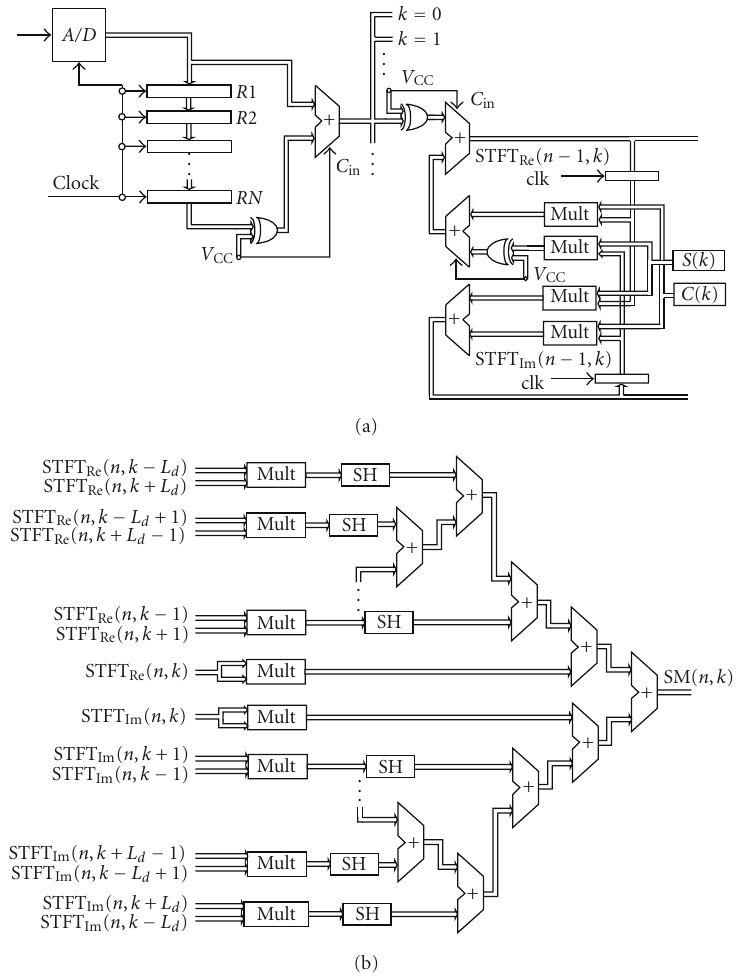
Figure 2: Architecture for realization of (a) STFT and (b)